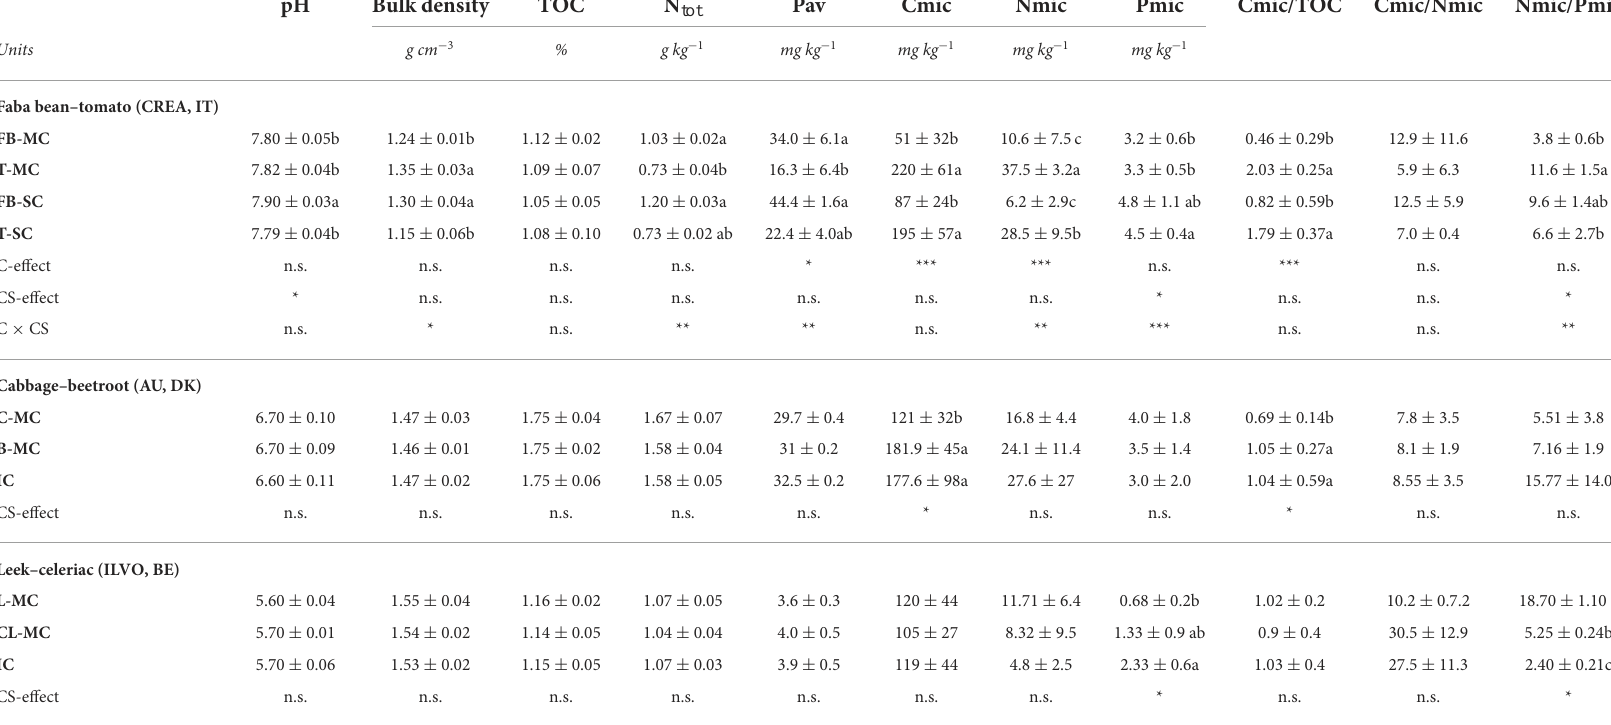
TABLE 2 Soil chemical, physical and stoichiometric parameters at CREA, AU, and ILVO sites in 2019, namely: pH, bulk density (g cm − 3 ), total organic C (TOC, %), total N (g kg − 1 ), available P (mg kg − 1 ),